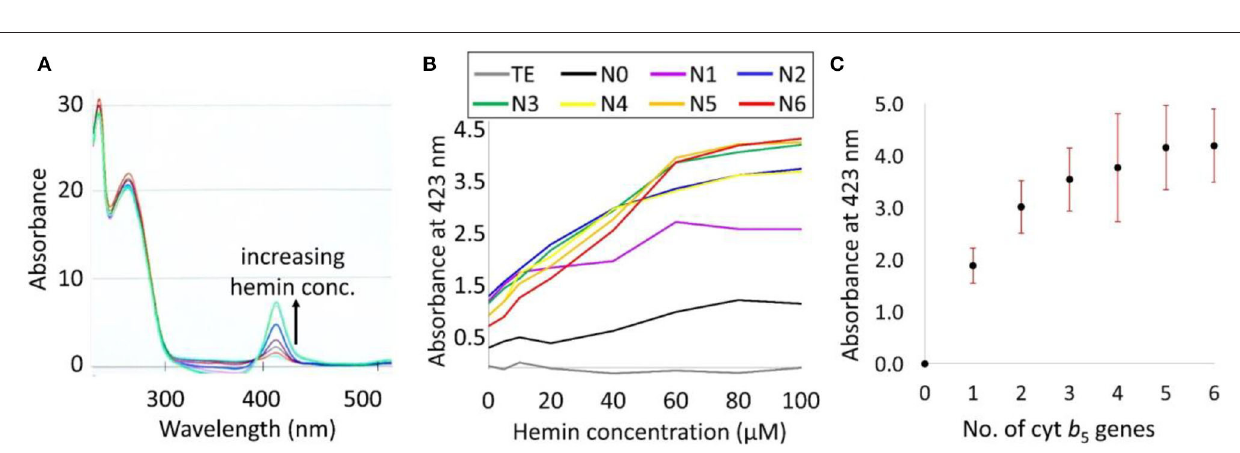
producing strains (N1–N6). A non- Cyt b 5 producing strain such as N0 showed no band in that region.